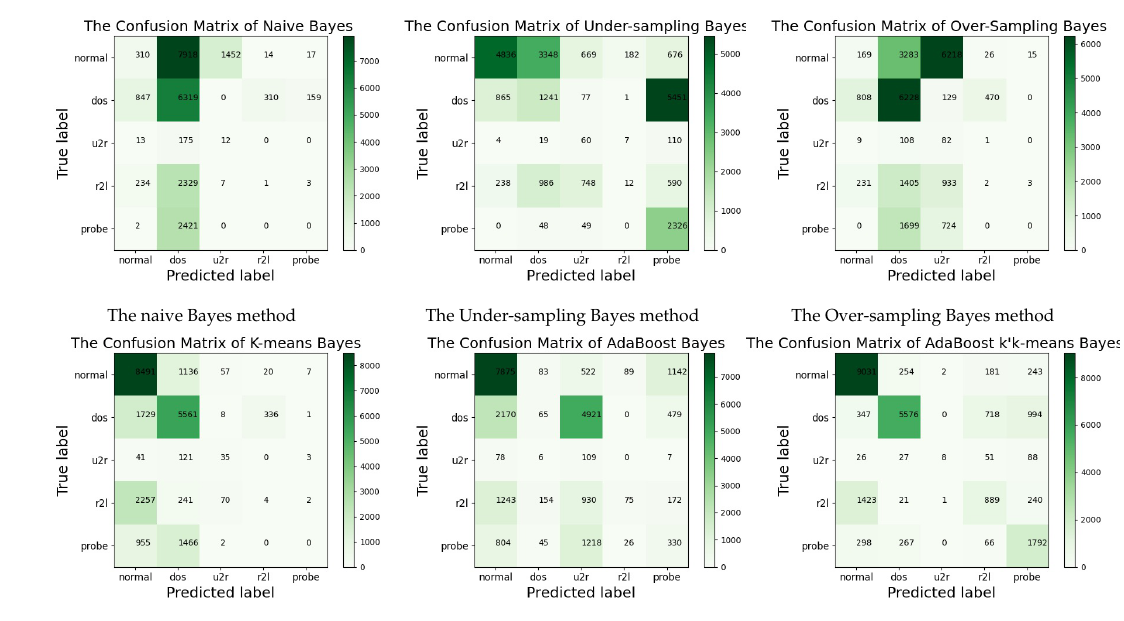
Figure 2. The confusion matrices of the six